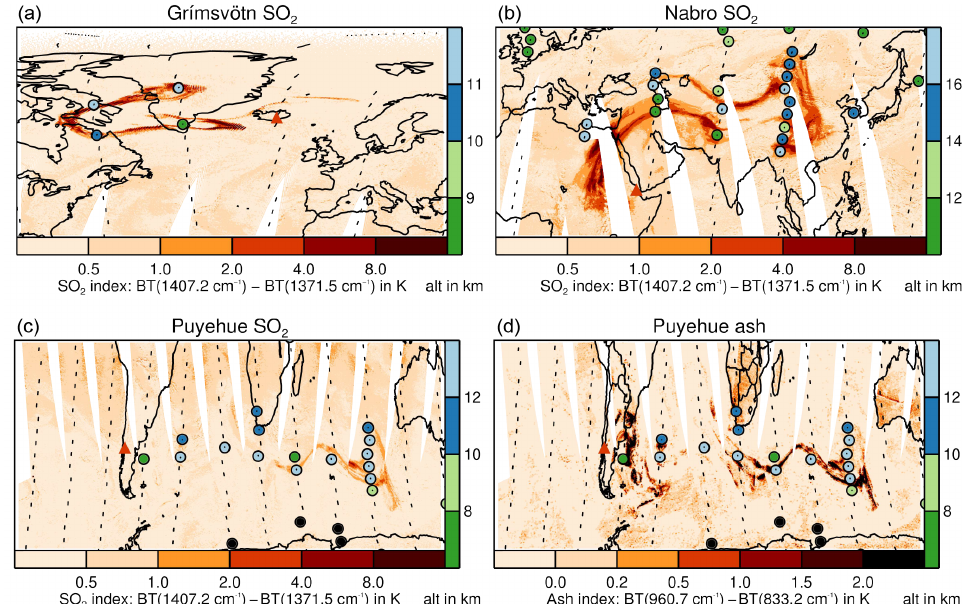
Figure 6. AIRS volcanic emission contours and MIPAS aerosol detections (coloured circles). (a) AIRS SO 2 index for Grímsvötn (27 May 2011, a.m.); (b) AIRS SO 2 index for Nabro (17 June 2011, a.m.); (c) AIRS SO 2 index for Puyehue–Cordón Caulle (9 June 2011, p.m.); (d) AIRS ash index for Puyehue–Cordón Caulle (9 June 2011, p.m.). Non-ice PSCs in the Antarctic at altitudes above 18km are coloured in black. The red triangles indicate the location of the respective volcanoes. Please note the different altitude